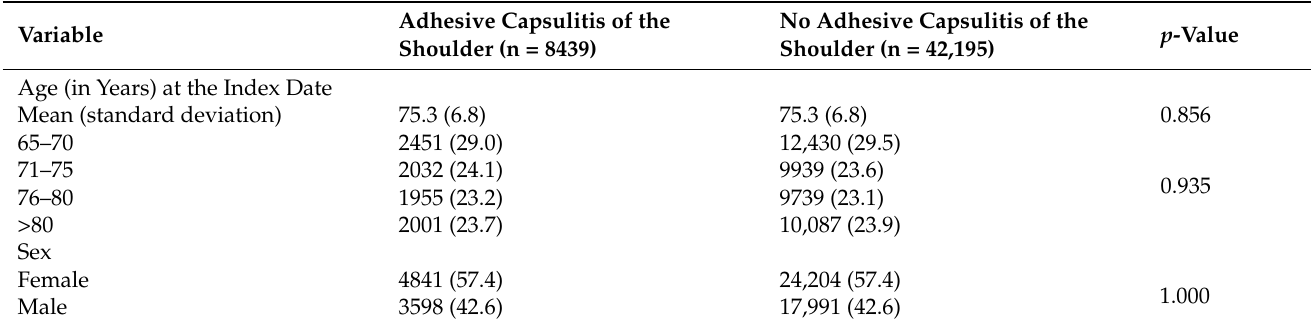
Table 1. Demographic characteristics of the study patients after 1:5 matching.